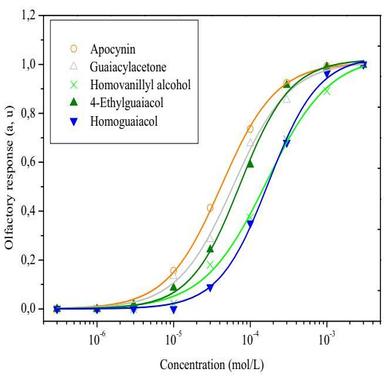
Experimental concentration-olfactory response curves fitted with the monolayer adsorption model with identical and independent binding sites for apocynin, guaiacylacetone, homovanillyl alcohol, 4-ethylguaiacol, homoguaiacol.